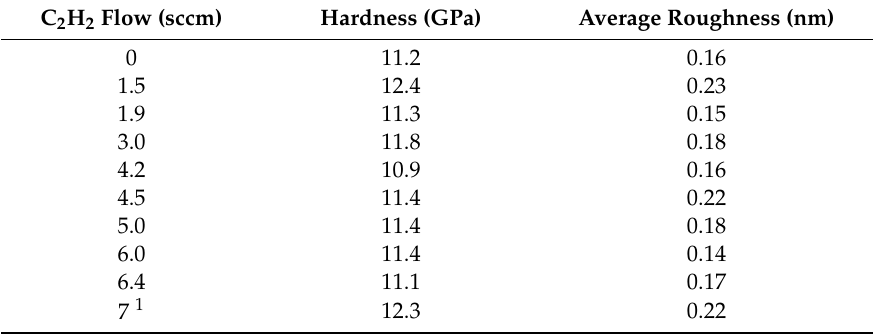
Table 1. Hardness and average roughness Ra of the (N-)DLC samples prepared with di ff erent C 2 H 2 flow.